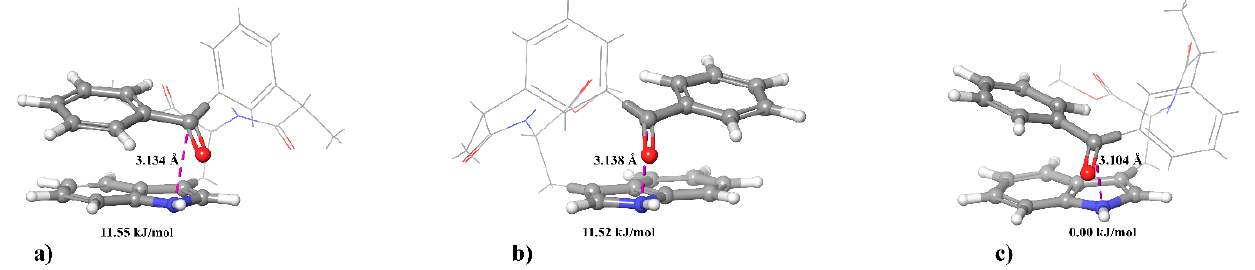
Figure 7. Structural parameters of optical isomers ( a ) ( R,S )-; ( b ) ( S,R )-; ( c ) ( S,S )- of dyad IV: Gibb’s energy values calculated under solvent conditions (acetonitrile, implicit solvation). Values in the gas phase are presented in Materials and Methods.